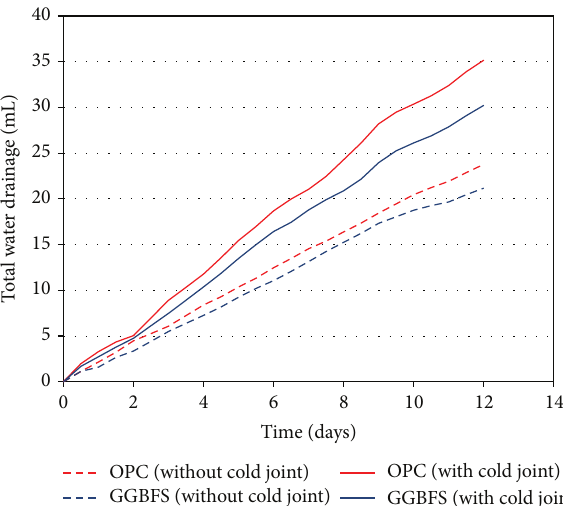
Figure 7: Compressive strength results at different ages.